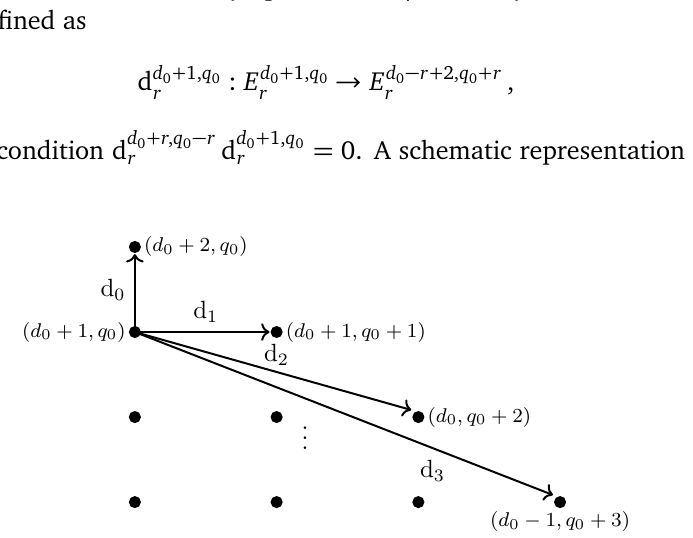
Figure 8: A pictorial representation of coboundary operators d r th